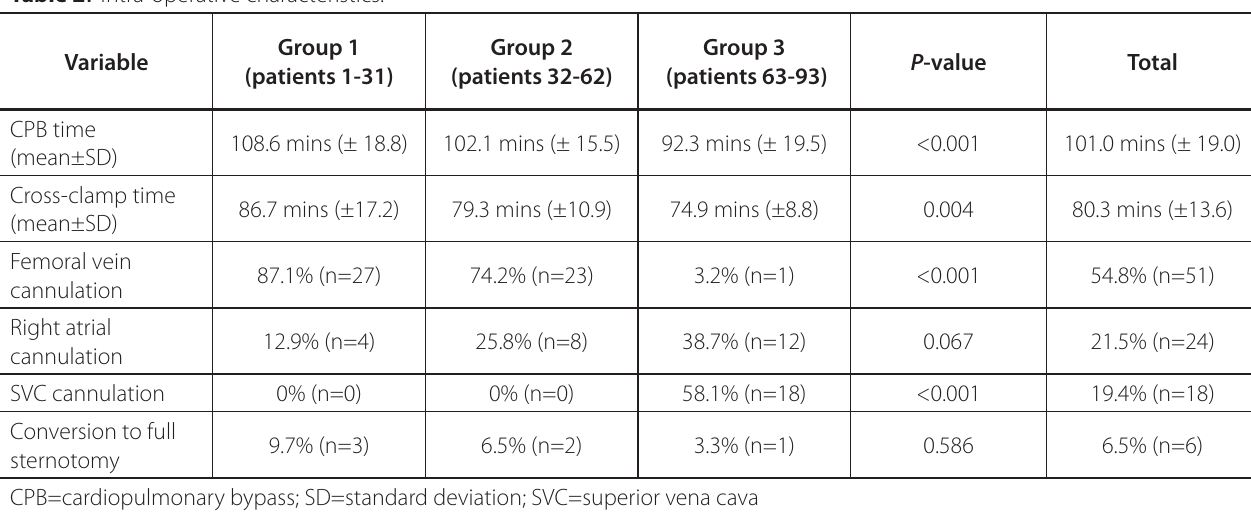
Table 2 . Intra-operative characteristics.